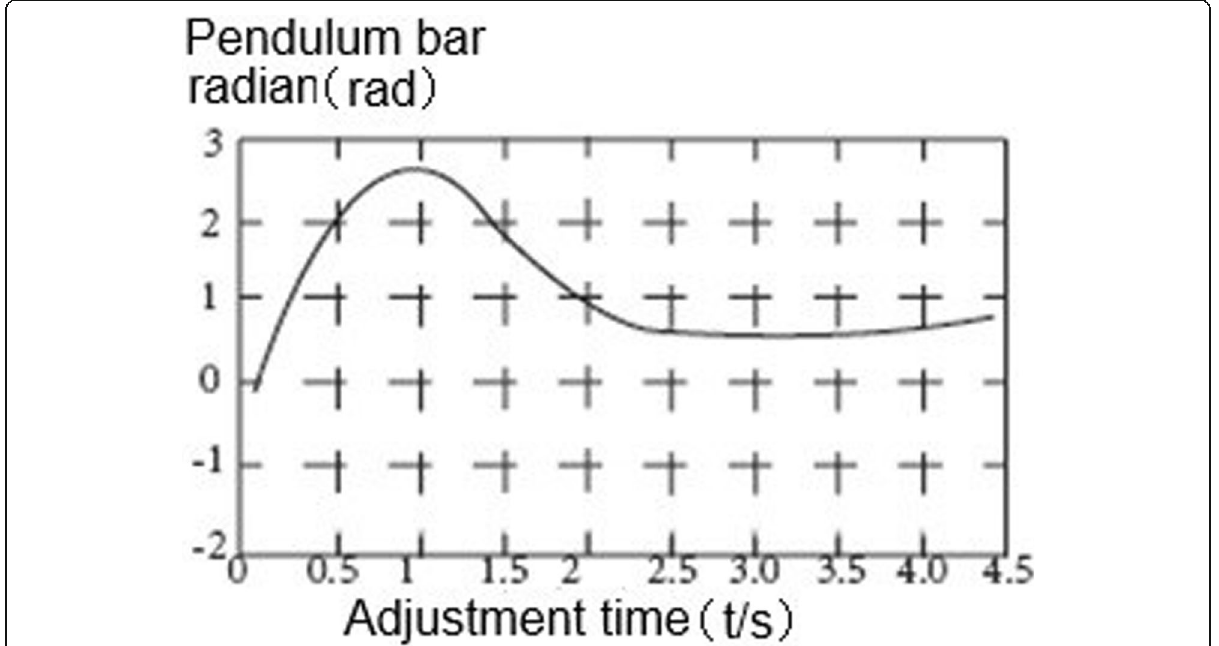
Fig. 4 The radian adjustment figure of the inverted pendulum by the method of